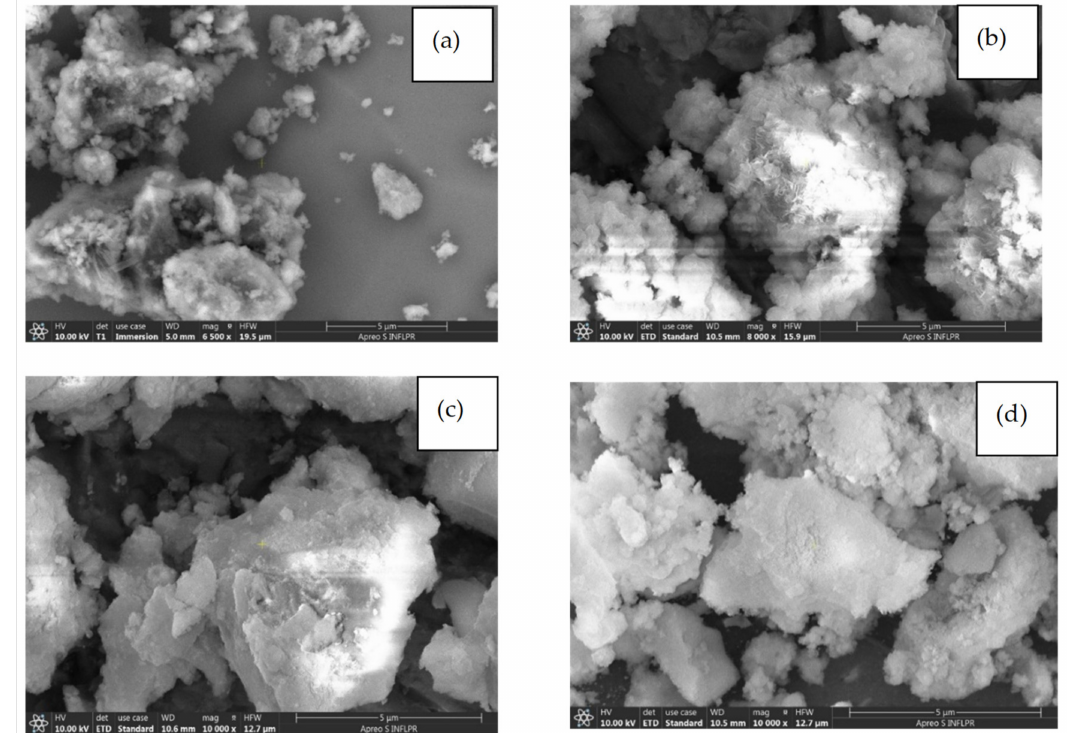
Figure 2. The SEM images of the LDHs modified with cerium: ( a ) HTCe-PP, ( b ) HTCe-MC, ( c ) Ce-PP, and ( d )